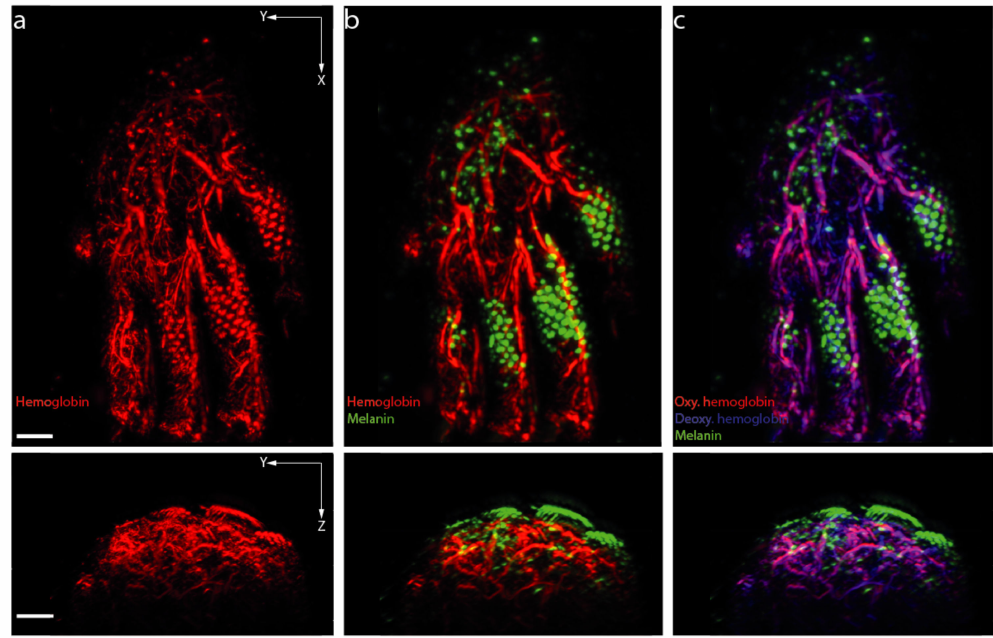
Figure 5. Raster-scanning optoacoustic mesoscopy (RSOM) of murine paw vasculature and the potential imaging readouts for inflammation. ( a ) Shows the hemoglobin signal representing the vascular network, which can be used to identify changes in blood volume; ( b ) multi-wavelength illumination enables the separation of melanin and hemoglobin signals; ( c ) further unmixing enables the visualization of oxygenation status of hemoglobin. Scale bar indicates